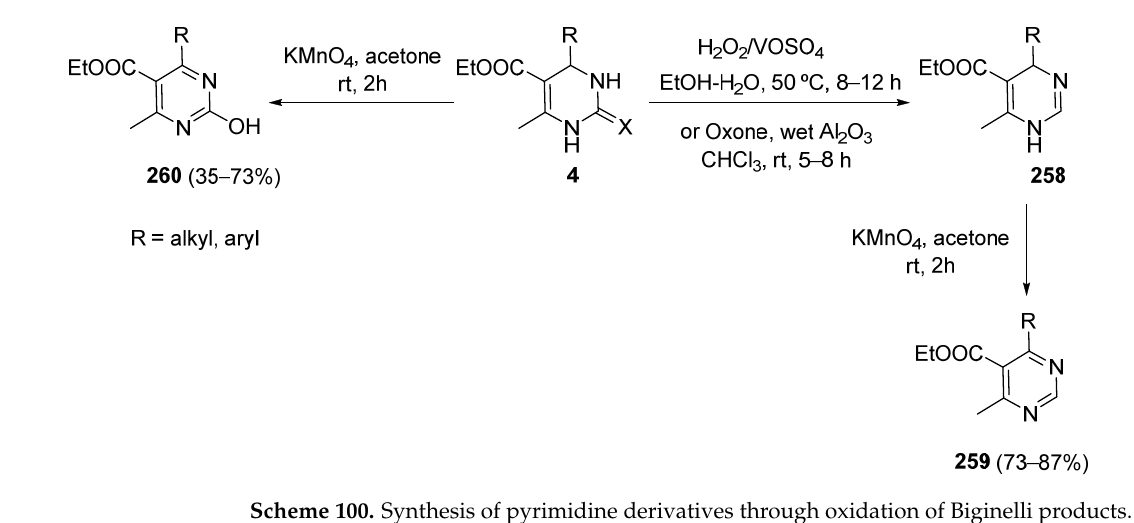
Scheme 100. Synthesis of pyrimidine derivatives through oxidation of Biginelli